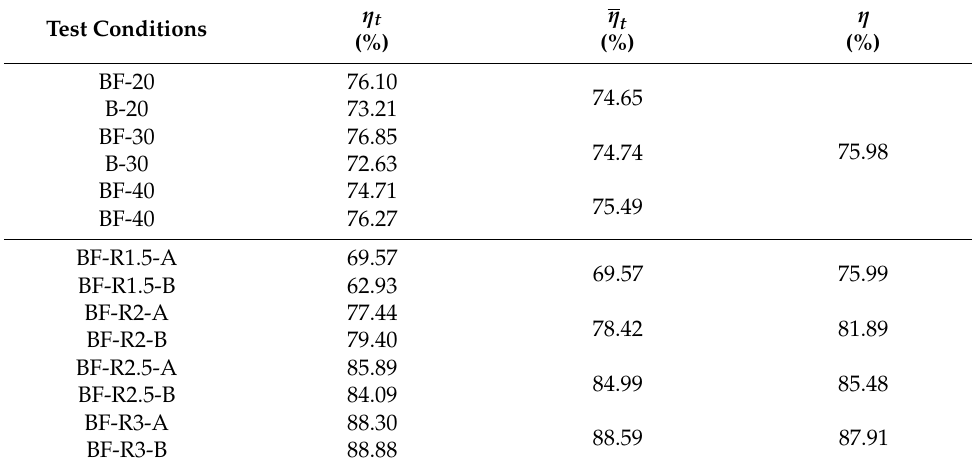
Table 6. Residual tensile strength under